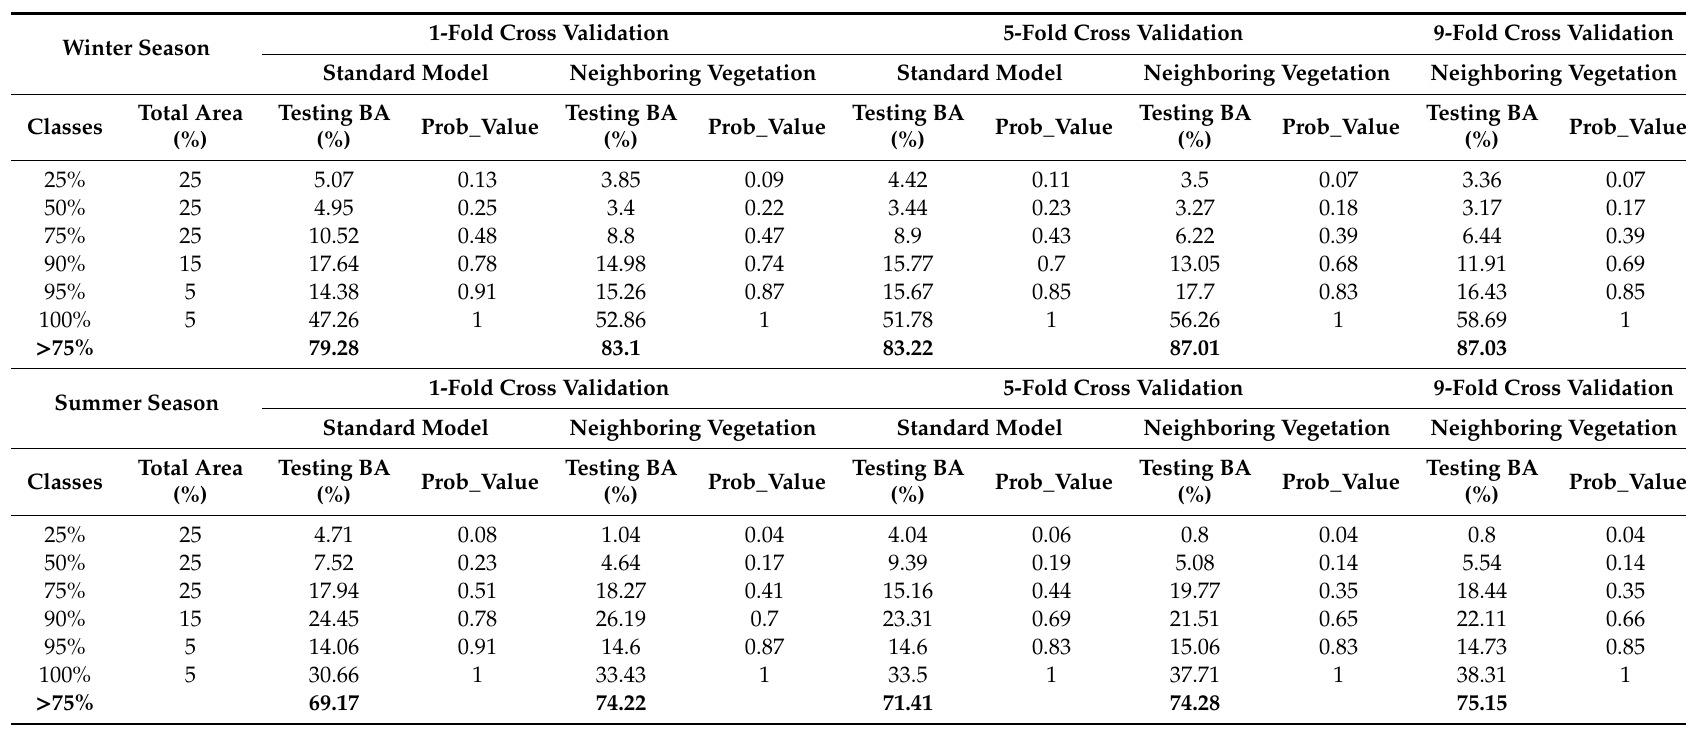
Table 2. Validation of the models (see Section 3.2 for more